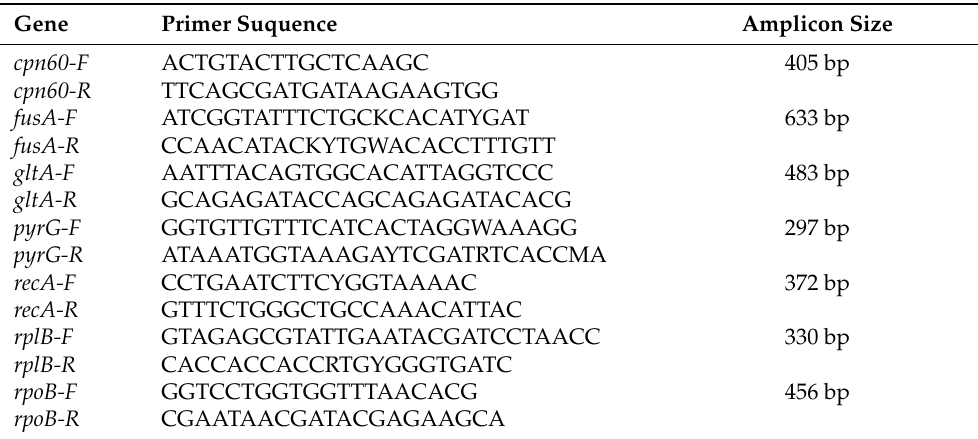
Table 3. Gene primers used for the detection of housekeeping genes by PCR in genes in CRAB-cc isolates in MLST